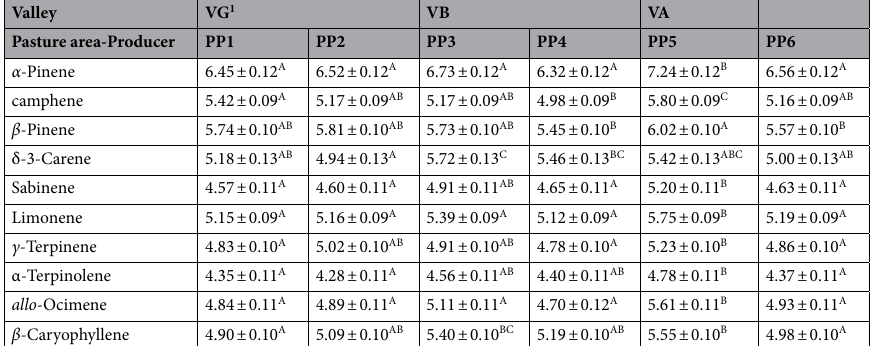
Table 2. Main terpenoids identified in Historic Rebel cheese according to Valley and Pasture area/Producer . VG Gerola valley, VB Brembana valley, VA Bitto di Albaredo valleys. Data expressed as the log10 of the area of the quant ion (LSM ± SEM). A,B,C Values within a row with different superscript letters differ significantly at P <